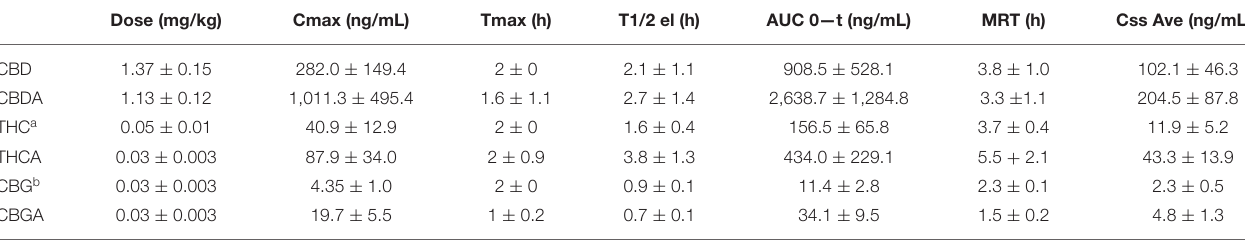
TABLE 1 | Twenty-four hour pharmacokinetic analysis of hemp derived cannabinoids (CBD, CBDA, THC, THCA, CBG and CBGA). Dose